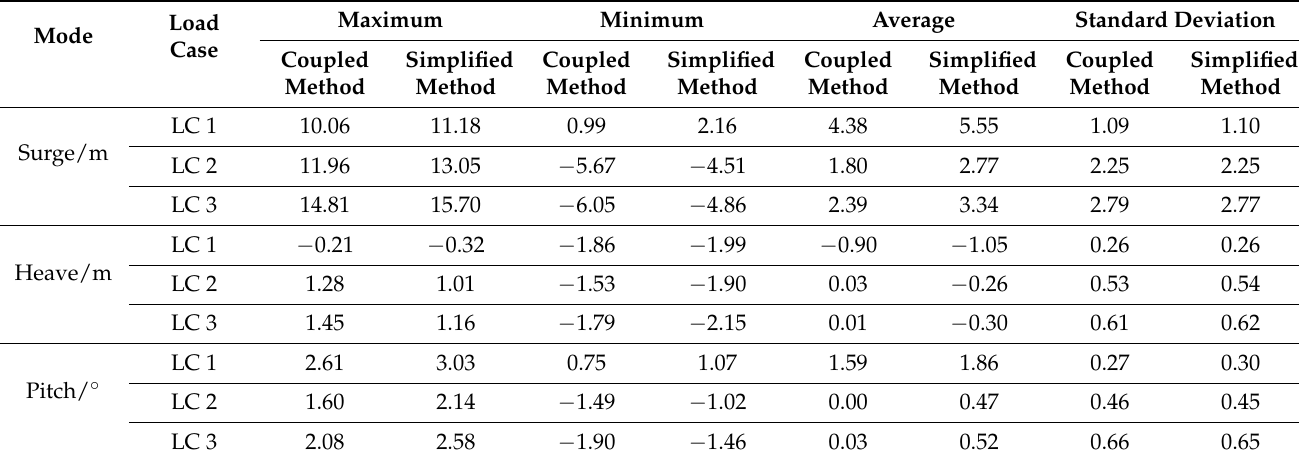
Table 6. Statistical results of WindFloat platform